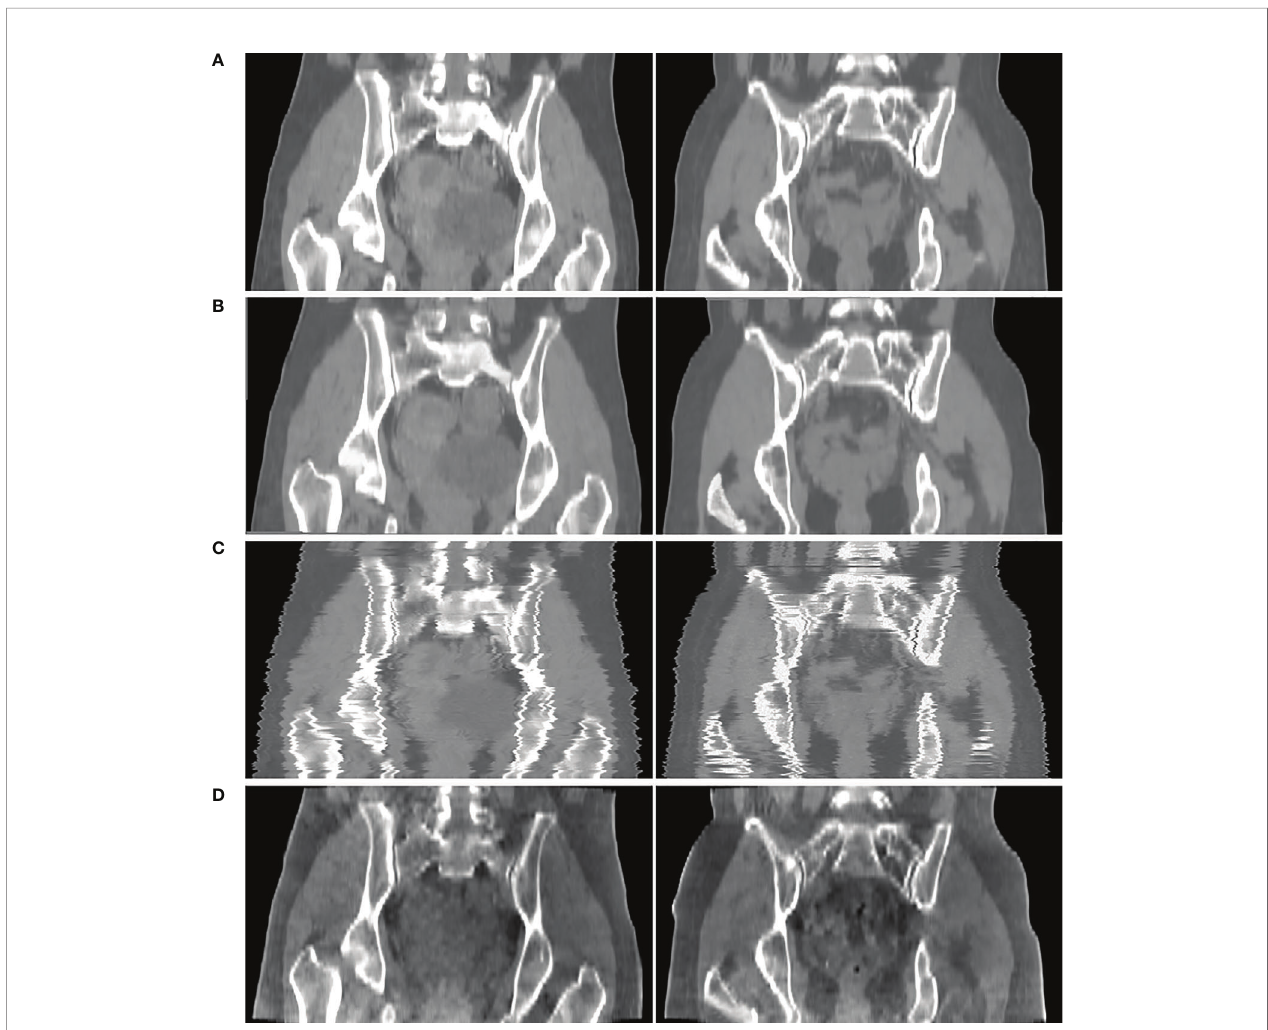
FIGURE 6 | Comparison results of CT gt and pseudo CT obtained based on 3D and 2D CycleGAN. (A) real CT images(CT gt ). (B) pseudo-CT images obtained based on 3D CycleGAN. (C) pseudo-CT images obtained based on 2D CycleGAN. (D) CBCT